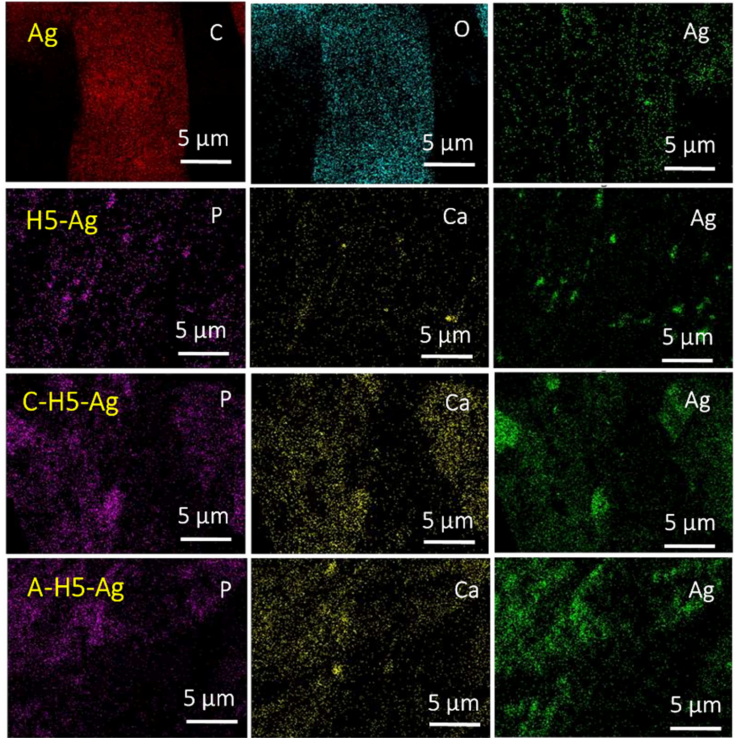
Figure 7. SEM-EDS analysis with the elemental mapping of cotton gauze samples coated with HAp- Ag NPs namely Ag-coated cotton gauze (Ag), Ag-HAp-coated cotton gauze (H5-Ag), cationized- HAp-Ag-cotton gauze (C-H5-Ag), and Anionic modified-HAp-Ag-cotton